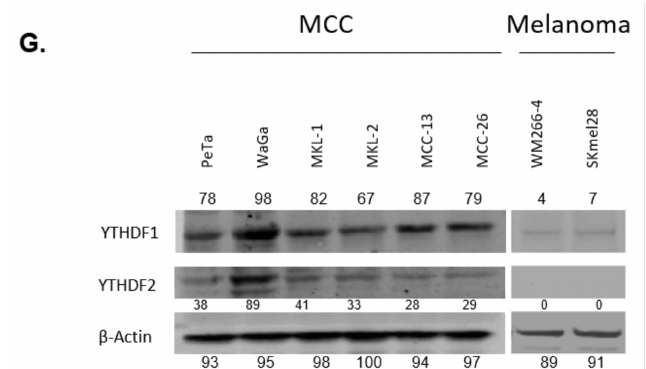
Figure 1. ( A ) Schematic overview of copy number variation and gene expression analysis, comparison of gene expression data with other types of skin cancer in the Cancer Cell Line Encyclopedia (CCLE), and validation process of the findings. ( B ) Intersection of genes with high copy numbers and highly expressing genes across all tested Merkel cell carcinoma (MCC) cell lines (FDR < 0.05). ( C ) Copy number gain in YTHDF1 and adjacent loci across all MCC cell lines. Inset shows YTHDF1 region in PeTa cell line. ( D ) YTHDF1 and YTHDF2 gene expression in skin cancers (other than MCC) from CCLE database compared to their expression in MCC cell lines. ( E ) Fluorescent in situ hybridization (FISH) ratio in MCC cell lines (fibroblasts are used as control cells, WM226-4 and SKmel28 are melanoma cell lines). ( F ) Correlation between YTHDF1 expression and amplification in MCC cell lines. ( G ) Western blot showing the expression of YTHDF1 in several MCCs and melanoma cell lines (upper panel) and the expression of YTHDF2 in the same cell lines (middle panel). Lower panel shows the expression of the internal control, β -actin. ** p <